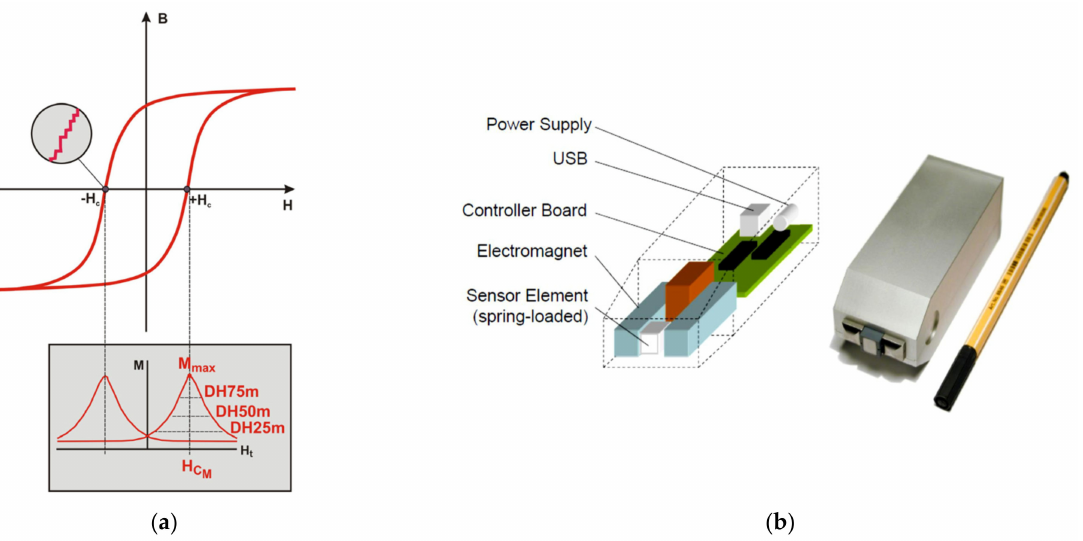
Figure 3. ( a ) Barkhausen noise profile curve in connection with the hysteresis curve and ( b ) Micro- Mach sensor construction